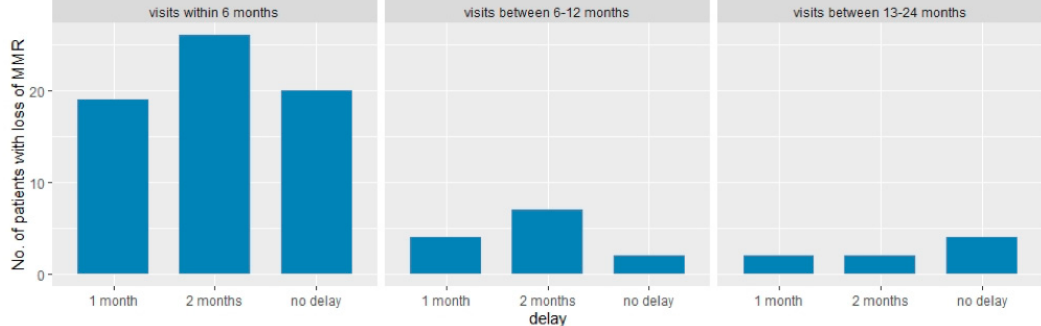
Figure 2. Delay of MMR (major molecular response) loss detection by timeframe if 3-month monitoring schedule is applied in our